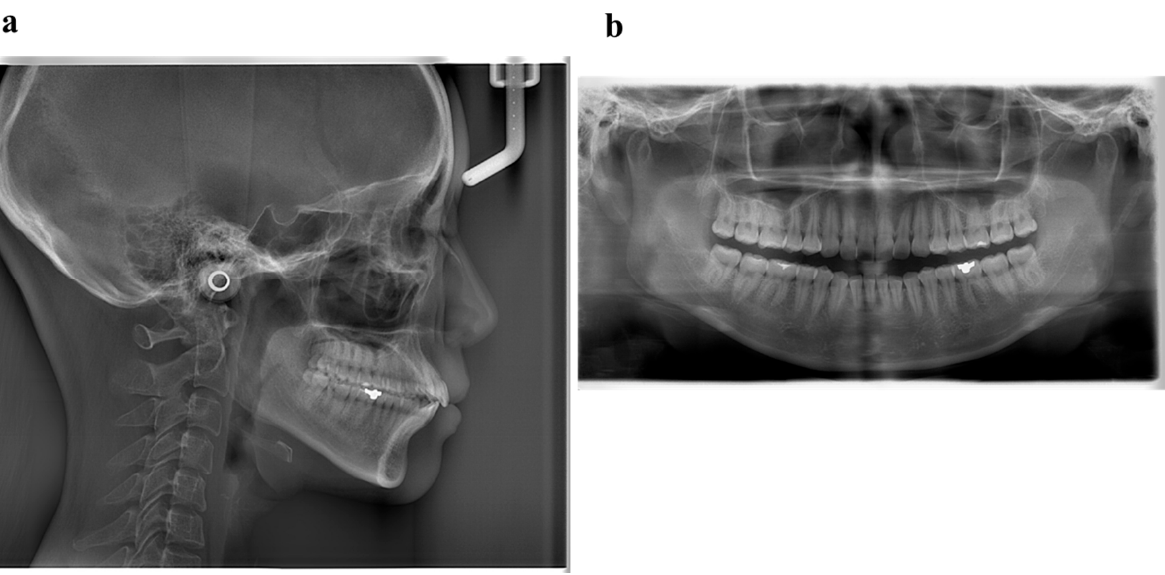
Figure 10. Pretreatment radiographs ( a ), lateral cephalogram; ( b ), panoramic radiograph). Table 5. Cephalometric analysis before treatment and post-treatment.